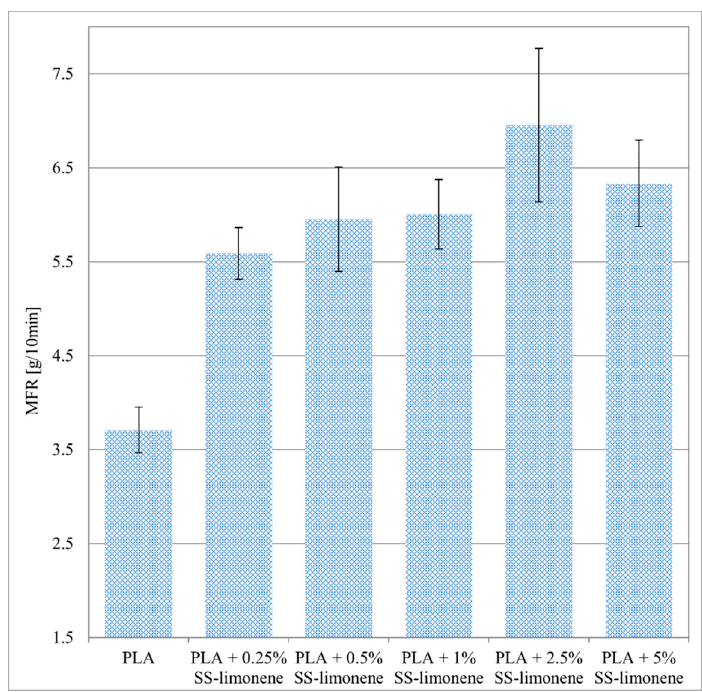
Figure 2. Result of MFR measurements.